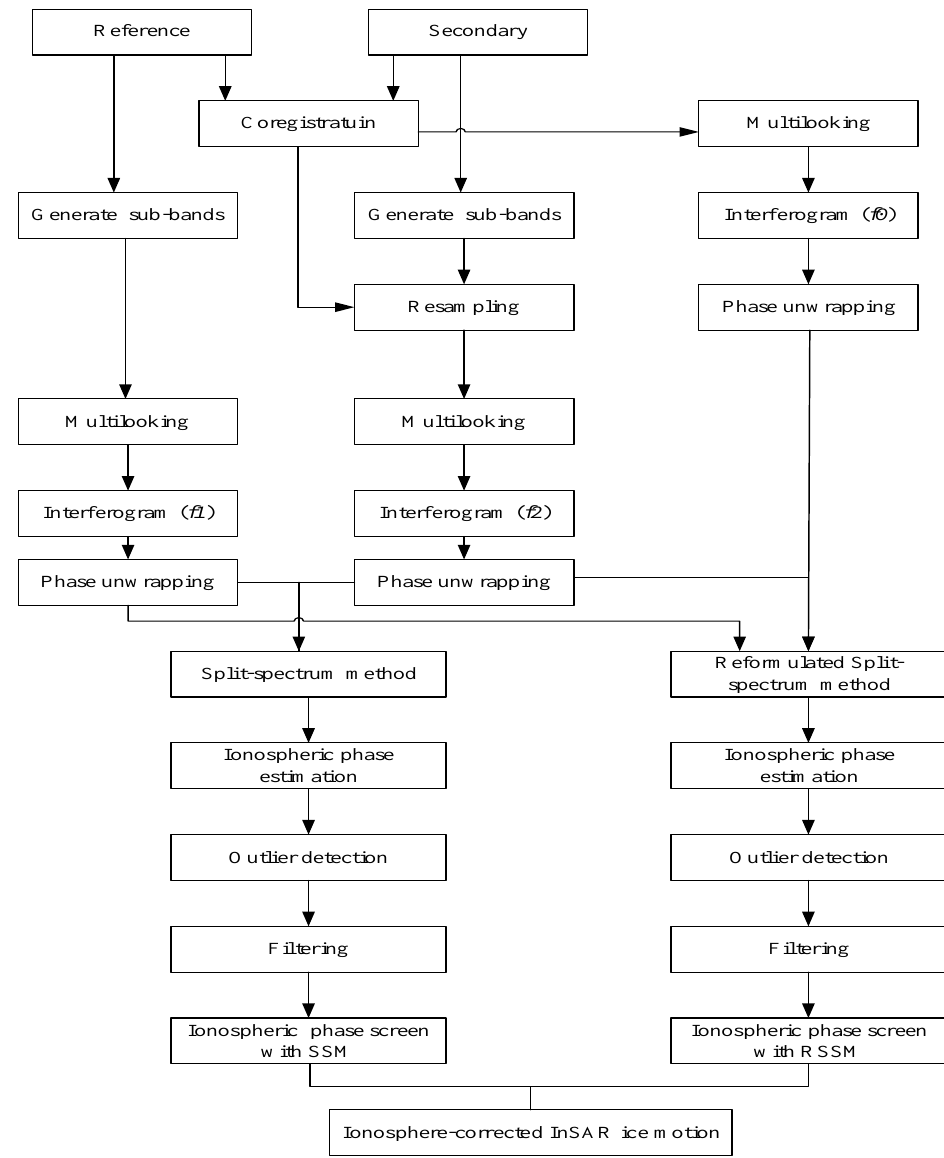
Figure 3. Data process of the ionospheric-phase estimation and correction for ALOS PALSAR.